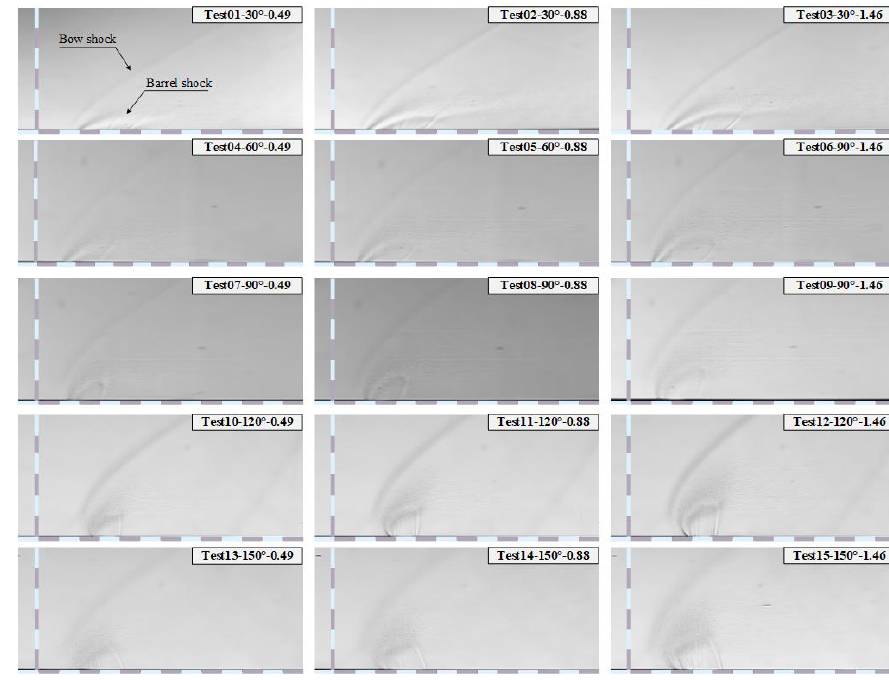
Figure 12. Diagram of the average flow field for all the tests, see the legends.